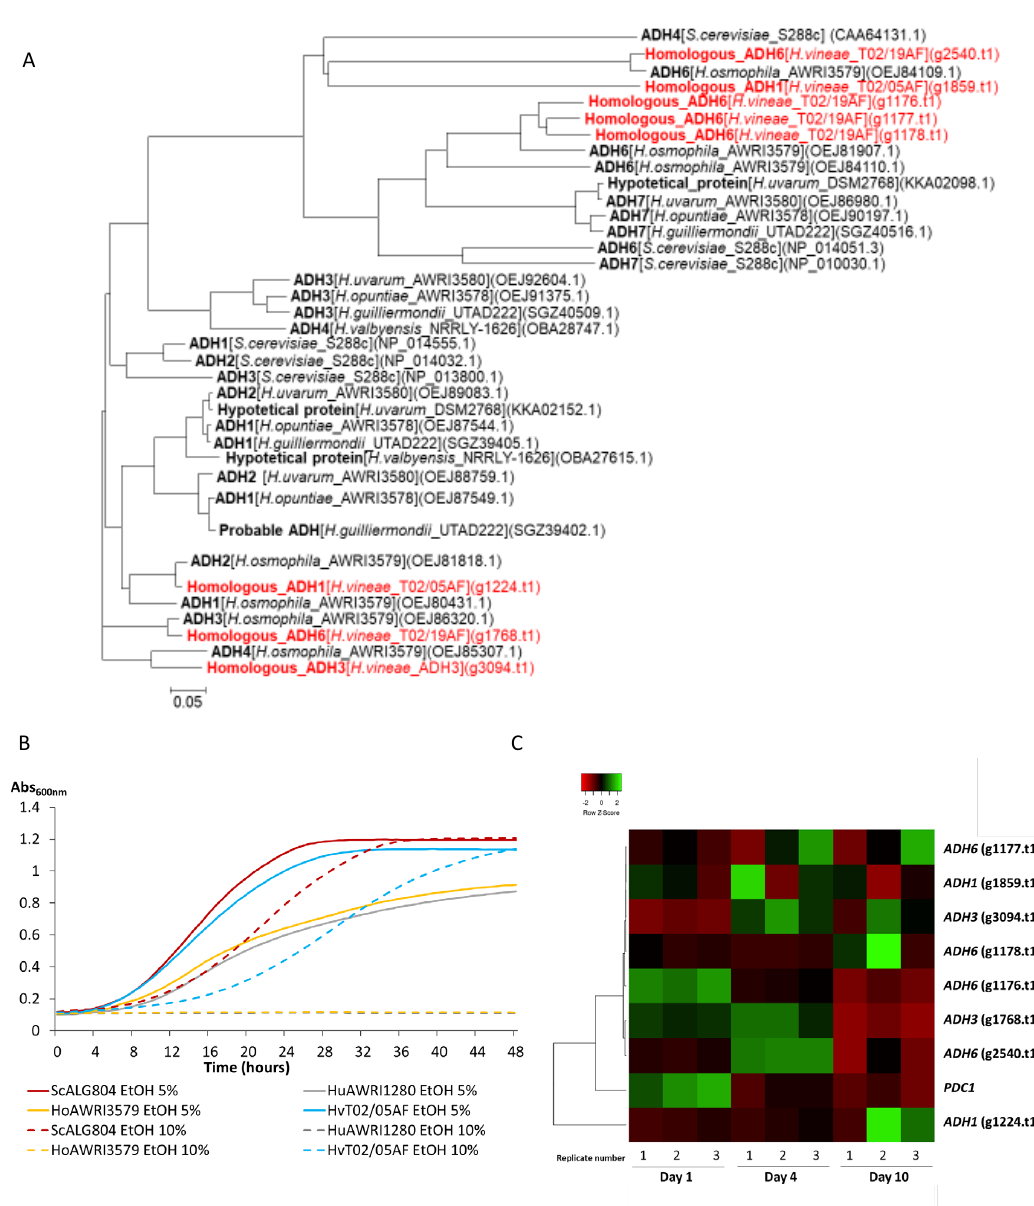
Figure 5. Characteristics that facilitate fermentation. ( A ) Dendrogram depicting relationships between the predicted amino acid sequences of several putative ADH genes. Hanseniaspora vineae sequences are indicated in red. ( B ) Growth of Hanseniaspora species and Saccharomyces cerevisiae in synthetic wine containing 5% of ethanol (solid line) and 10% ethanol (dotted line) for 48 h. Error bars are not shown to enhance clarity. SD < 0.05 for all samples. ( C ) A heatmap depicting expression levels of genes putatively involved in glycolytic pathways in H. vineae after 1, 4, and 10 days of fermentation. Green and red colours indicate high and low levels of expression, respectively. Data are shown in triplicate.